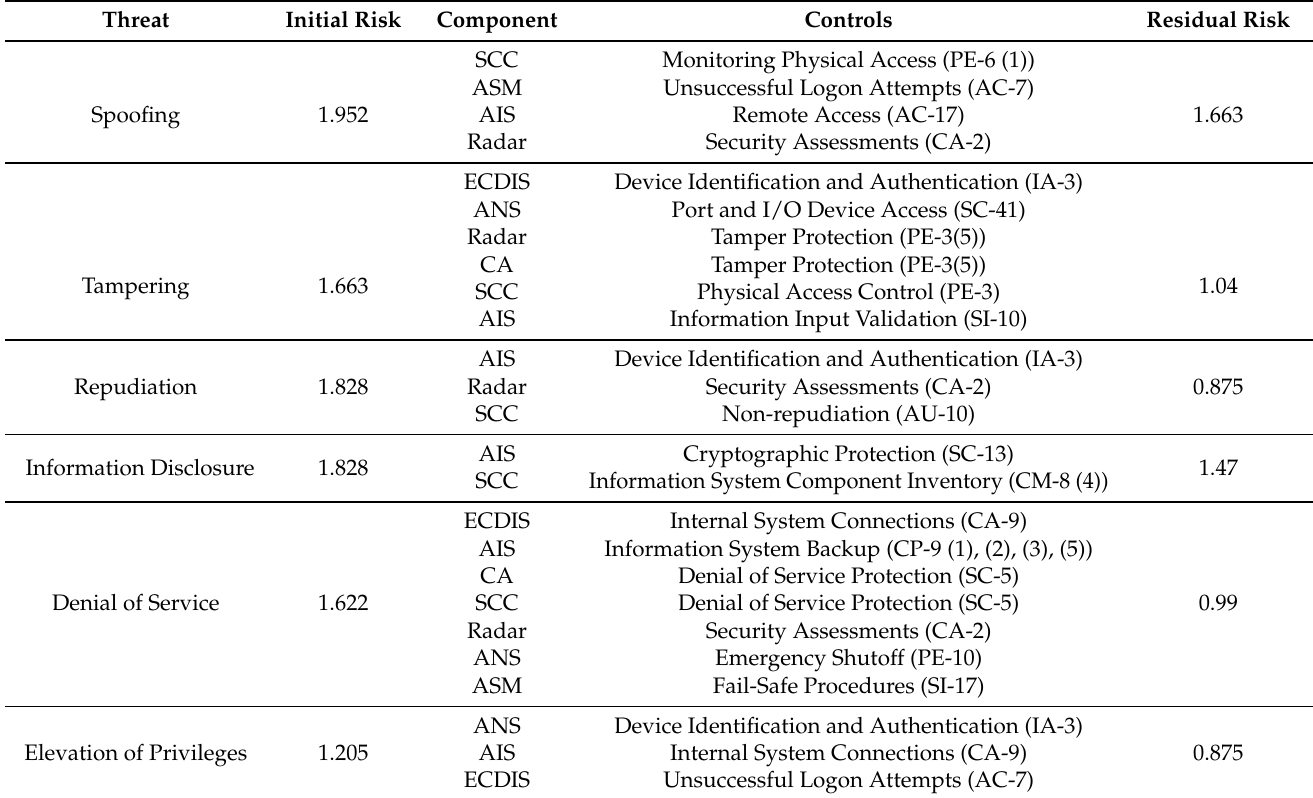
Table 7. Optimal controls–Remotely controlled